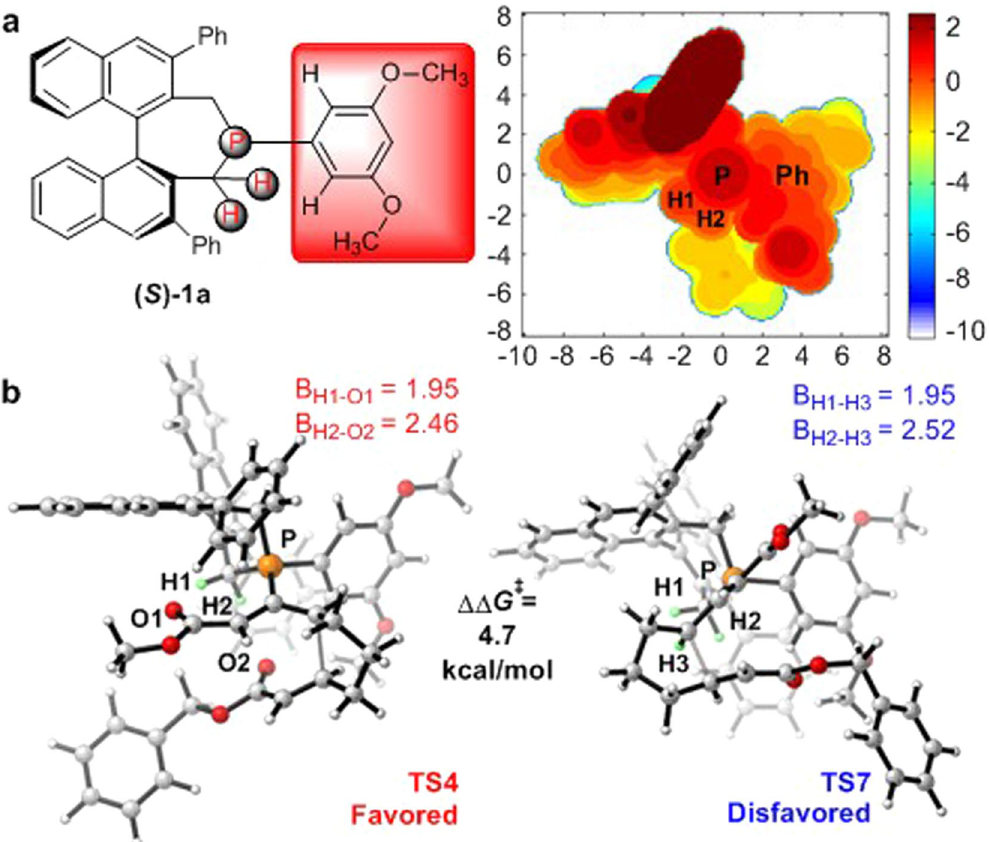
Figure 11. ( a ) 2D contour map of the Van der Waals surface of catalyst ( S )-1a . Distances are given in angstroms. P atom is located at the origin of the coordinate system in the contour map. The contour line of zero is defined as in the same plane of the P atom. Negative distance (blue) indicates that the atoms on the ligand are farther away from the substrate; positive distance (red) indicates that the atoms on the ligand are closer to the substrate. ( b ) Geometries of transition states TS-4 and TS-7 with catalyst ( S )-1a . The values of bond lengths are given in